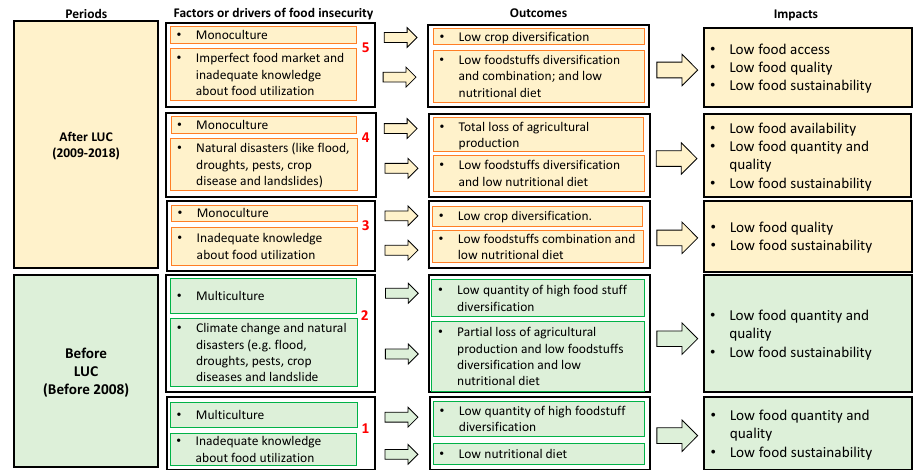
Figure 6. Scenarios showing the failure of LUC to ensure food security in Nyange Sector.